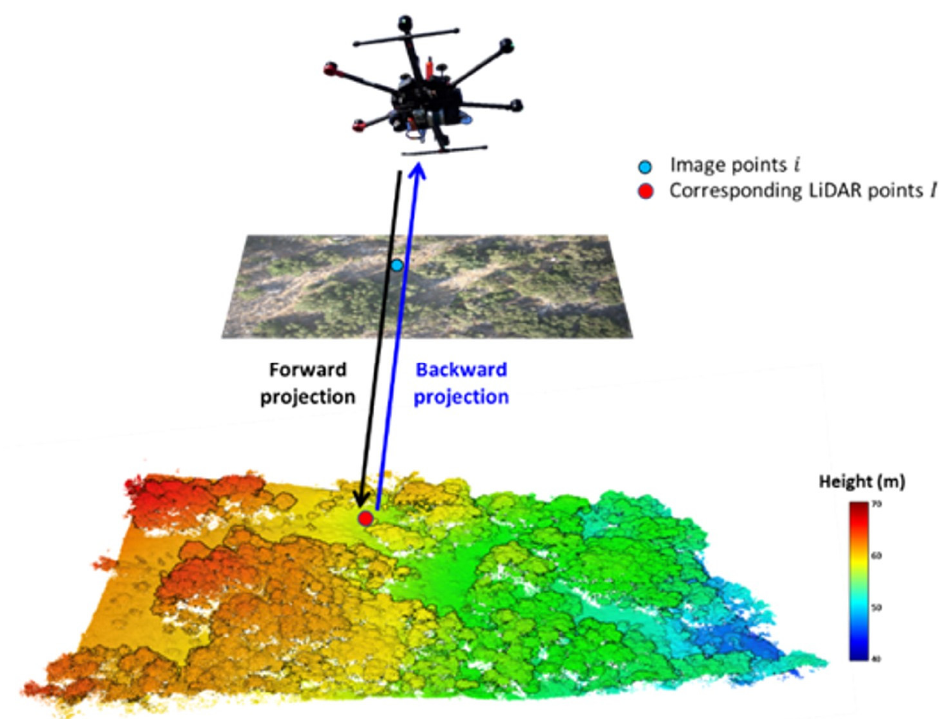
Figure 6. Illustration of backward and forward projection processes for visualization.